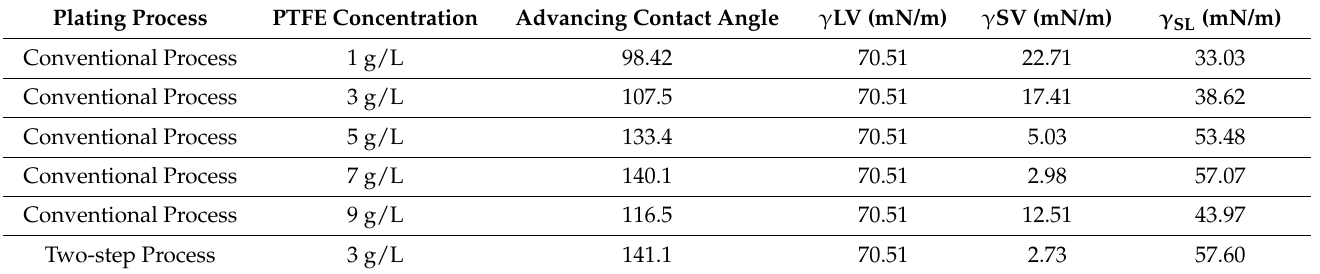
Table 2. Surface energies of the Ni-P-PTFE plating layers for different PTFE concentrations and processes.